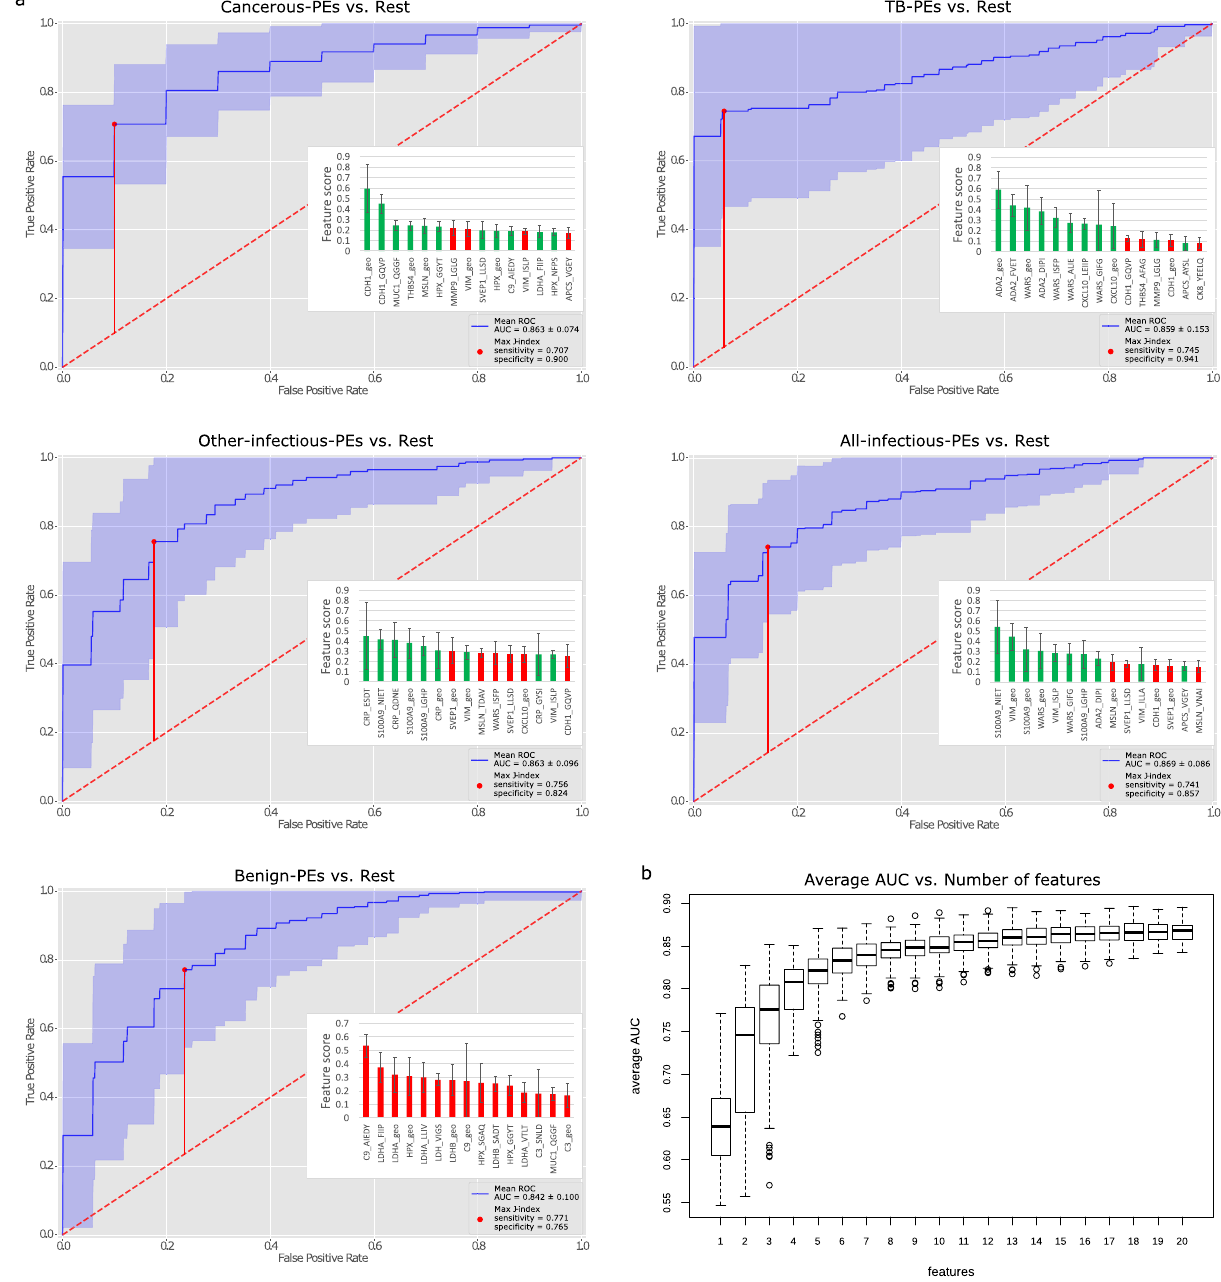
Figure 3. Performance of classifier at discriminating PEs into five etiology classes. ( a ) ROC curves showing diagnostic efficacy of classifier discriminating PEs into one of five etiology classes. Average AUC is displayed (blue line) with the ± standard deviation shaded (violet). An optimal %-sensitivity/%-specificity cut-off point is suggested by the maximum value of the Youden’s index (vertical red line: Max J-index). For each classification, the 15 most influential features (individual protein peptide measurements or geometric means of multiple peptide values) used by the classifier are indicated (inset graph), with an indication if they had an increased (green) or decreased (red) level in the PE group. ( b ) Graph of average classifier AUC versus number of features used in total for the four classifications of cancerous-, TB-, other-infectious-, and ability as judged by the AUC, but especially by an increase in sensitivity at 100% specificity (zero false positive rate: 0 FPR). The prediction of cancerous-PEs and TB-PEs was especially effective, with a sensitivity of 55% and 67%, respectively, at a 0 FPR. The classifier discriminated the cancerous-PEs from the rest of PEs with an AUC of 0.863 ± 0.074, and with a 71% sensitivity and 90% specificity. The feature with the highest score was the level of CDH1, followed by lower-scoring elevated measurements for MUC1, THBS4, MSLN, and HPX. For the discrimination of TB-PEs an AUC of 0.859 ± 0.153 was obtained, with a 75% sensitivity and 94% specificity.